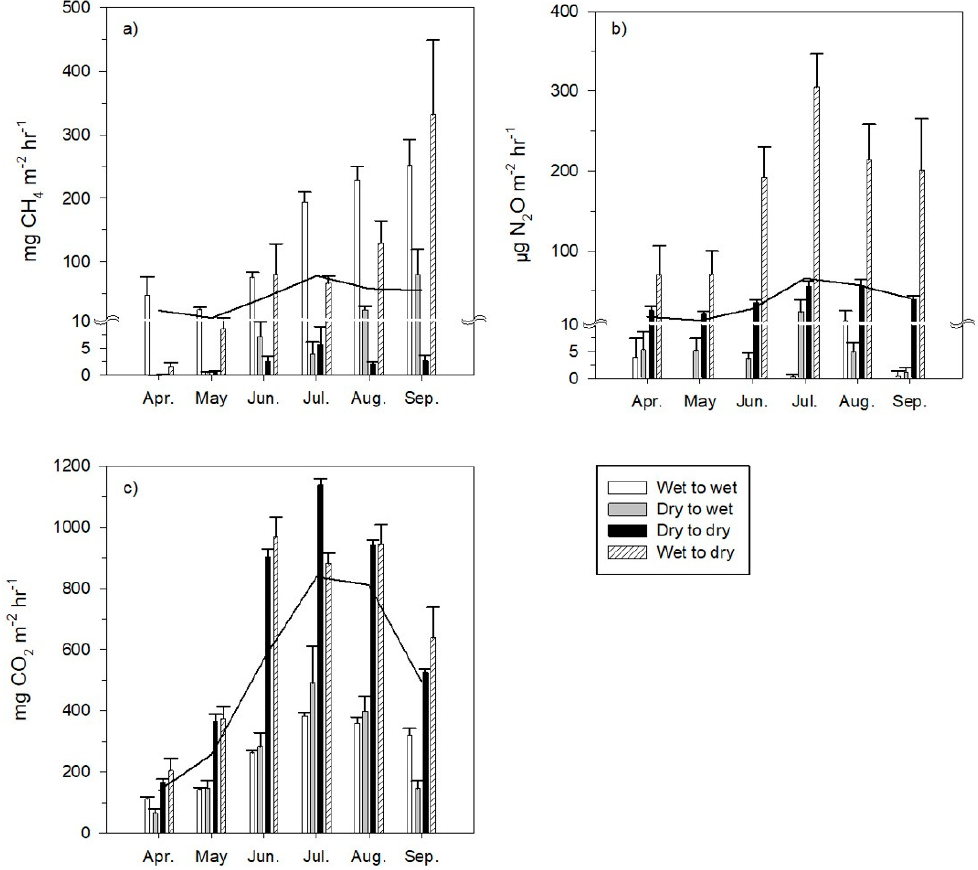
Figure 4. Average (arithmetic mean ± standard error) monthly ( a ) CH 4 , ( b ) N 2 O, and ( c ) CO 2 fluxes of seasonal Prairie Pothole Region wetlands by hydrologic state. The solid lines represent the average monthly (arithmetic mean) fluxes based on all sample locations and hydrologic states.